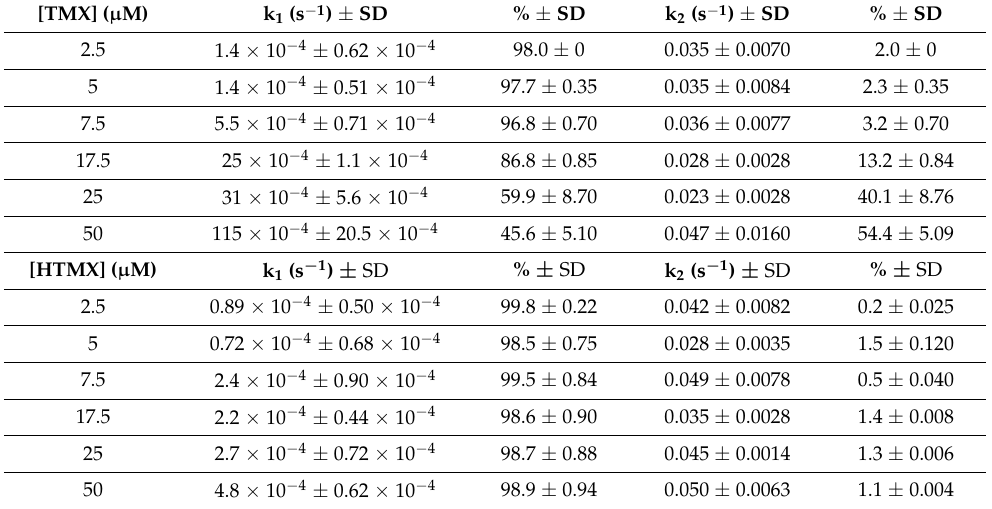
Table 1. Rate constants, and their relative proportions, for TMX- and HTMXinduced CF leakage from POPC unilamellar vesicles, as determined by fitting the data shown in Figure 2 to Equation (1). Data correspond to the mean of three independent experiments ± SD.